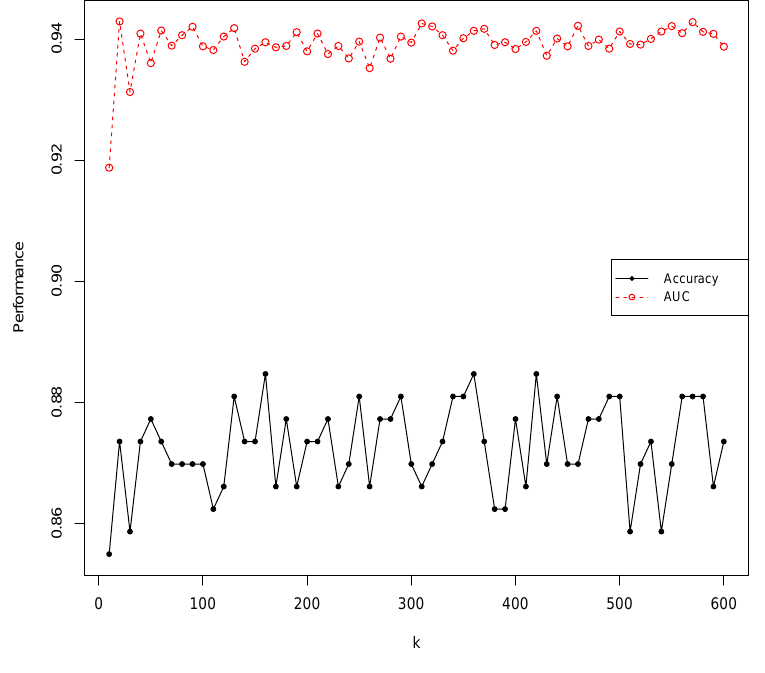
Figure 5. SSCTE’s performance with various amount of diversity